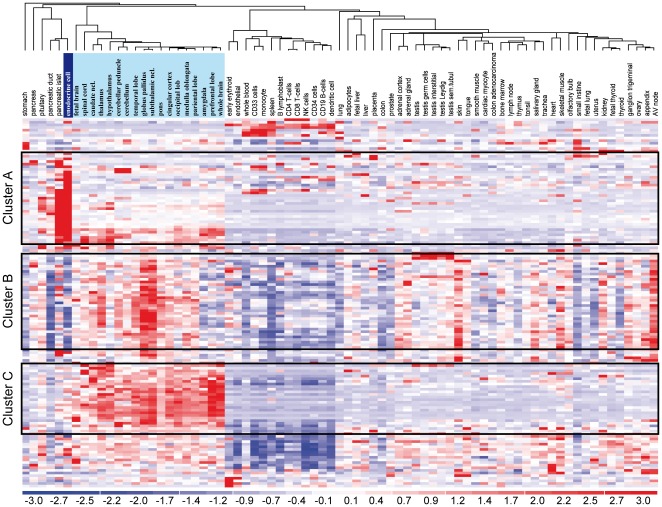
Ngn3 induces endocrine cell-enriched and neural-enriched genes in ducts.We analyzed all transcripts that are Ngn3-activated in suspension cultured duct cells (n = 140 on HG133A) in a public dataset of more than 50 human tissues and cell types (each n = 2), supplemented by our endocrine cell hybridizations (n = 3). The cluster graph thus shows the relative tissue-selectivity of the Ngn3-induced transcripts. Approximately 25% of Ngn3-regulated transcripts are selectively enriched in endocrine cells/pancreatic islets (cluster A). Cluster B genes are enriched in the central nervous system but generally not in pancreatic endocrine cells. Cluster C exhibit a neuro-endocrine expression pattern, with comparable expression in central nervous system and endocrine cells. An annotated version of Figure 1 with full gene names is included as Figure S2.